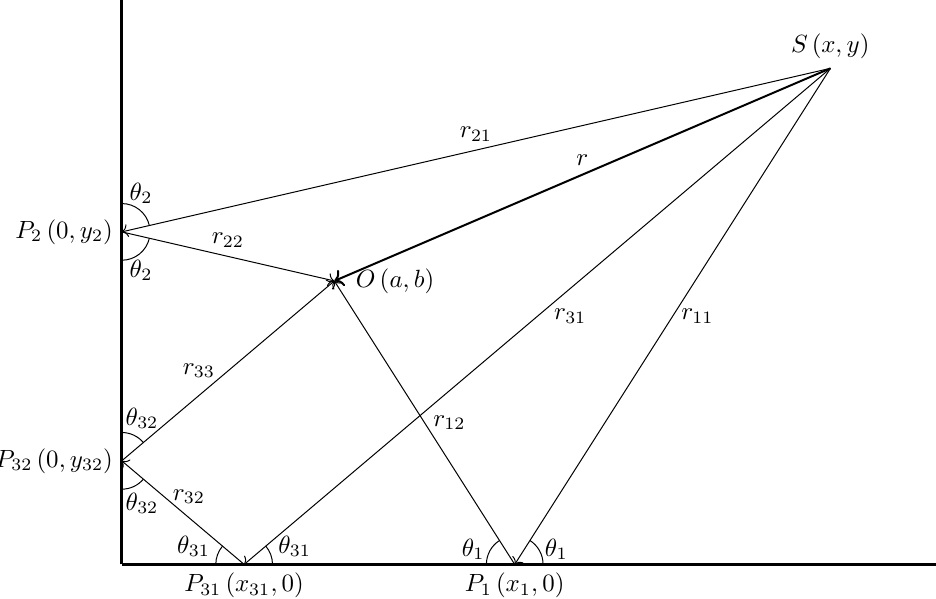
Figure 1: Observer O at ( a , b ) receiving from the source S at ( x , y ) four signals: (i) one direct from the source to observer at distance r ; (ii) one with the reflection on the ground making the distance r 11 + r 12 ; (iii) one with the reflection on the wall making the distance r 21 + r 22 ; (iv) one with the reflection on the ground followed by the reflection on the wall making the distance r 31 + r 32 + r 33 .